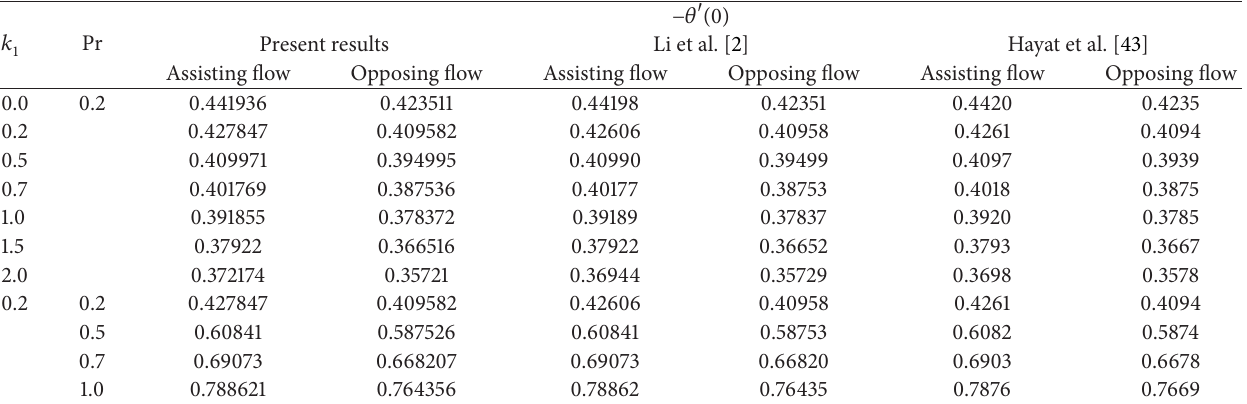
Table 2: Comparison of −𝜃 󸀠 (0) for various values of 𝑘 1 and Pr when 𝑚 = 1.0 and 𝜆 𝑇 = 0.2 .